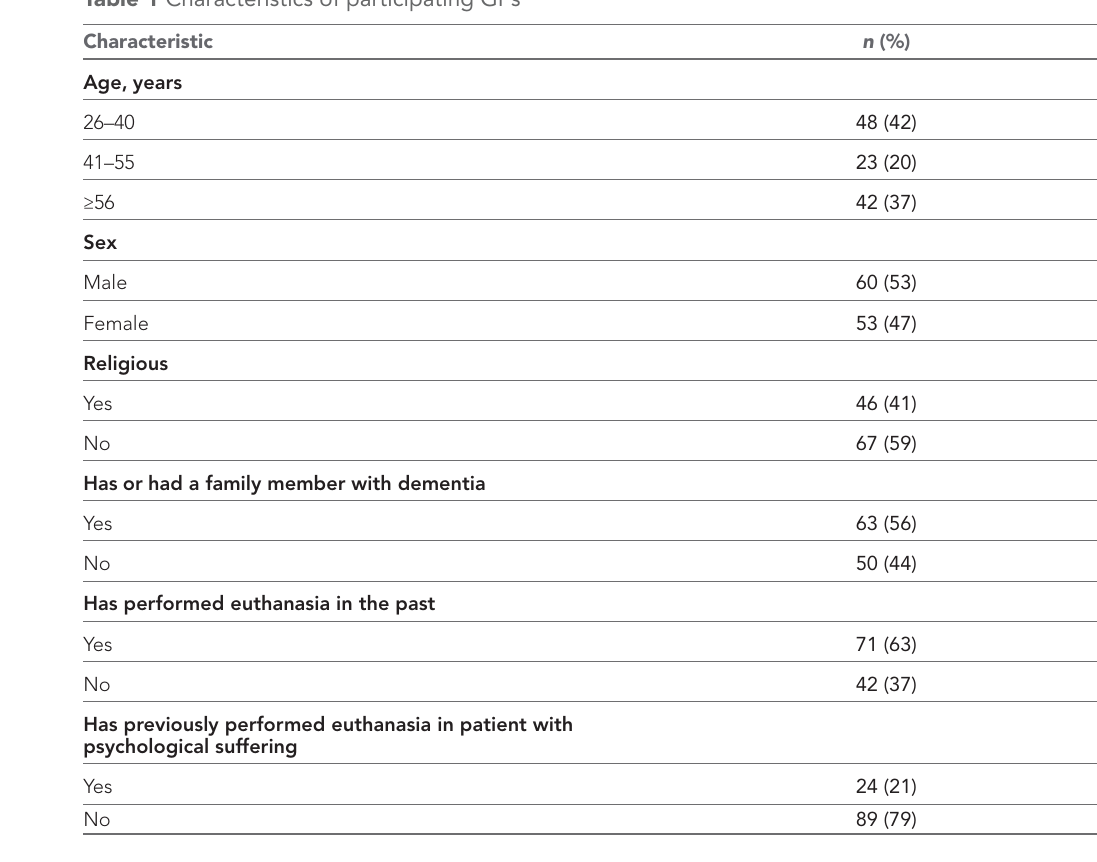
Table 1 Characteristics of participating